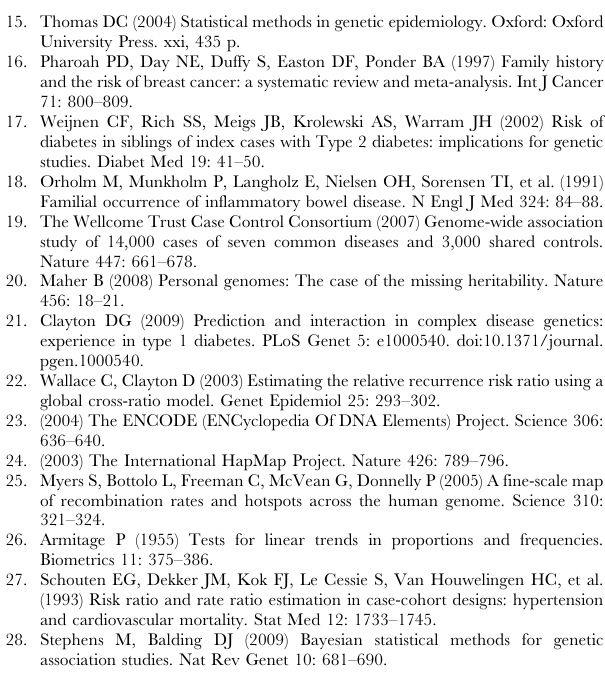
Table S4 Replicated SNPs for Crohn’s disease. (See main text for reference).